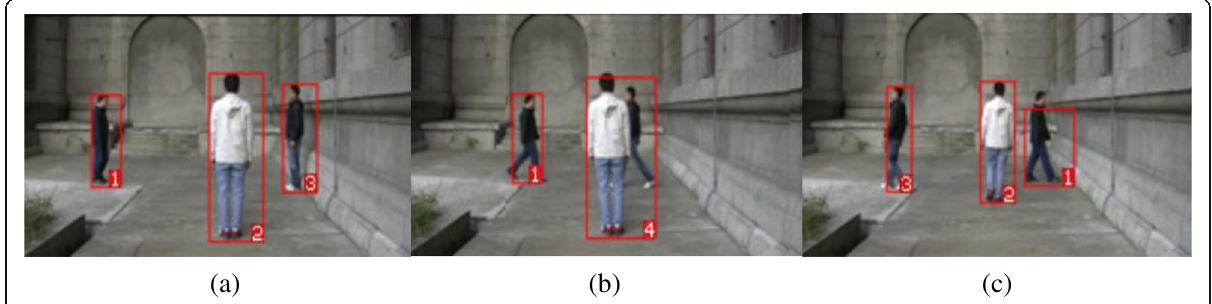
Fig. 5 Illustration of tracking three human targets in an outdoor scene. a Three human targets tracked with red rectangle bounding boxes labeled 1, 2, and 3. b Target labeled 2 and target labeled 3 merge together as a new target labeled 4. c Merged targets split into target labeled 2 and 3 by feature matching